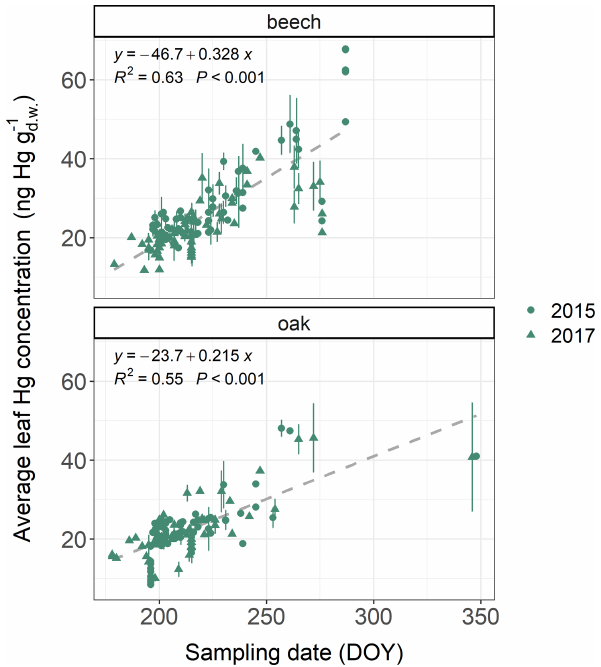
Figure 2. Average leaf Hg concentrations (ngHgg − 1 ) in beech and d.w. oak samples at multiple ICP Forests plots versus sampling dates (day of year: DOY) of respective samples. Sampling took place both in 2015 and 2017. Two plots of holm oak ( Quercus ilex ) are located in Greece and were sampled in December 2015 (DOY = 348) and December 2017 (DOY = 346). Error bars denote ± 1 standard de- viation between multiple samples at each forest